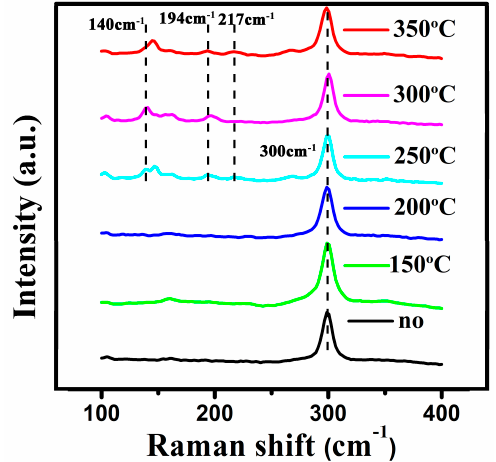
Figure 2. Raman spectra of Ni x Ge y films formed at various temperatures.